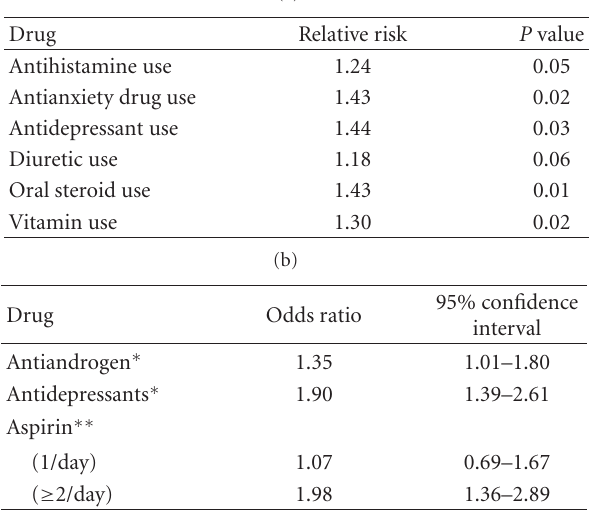
Table 2: (a) 10-year incidence of dry eye in older population— relative risk due to medication (Beaver Dam Study [10]). (b) Association of dry eye in older population due to